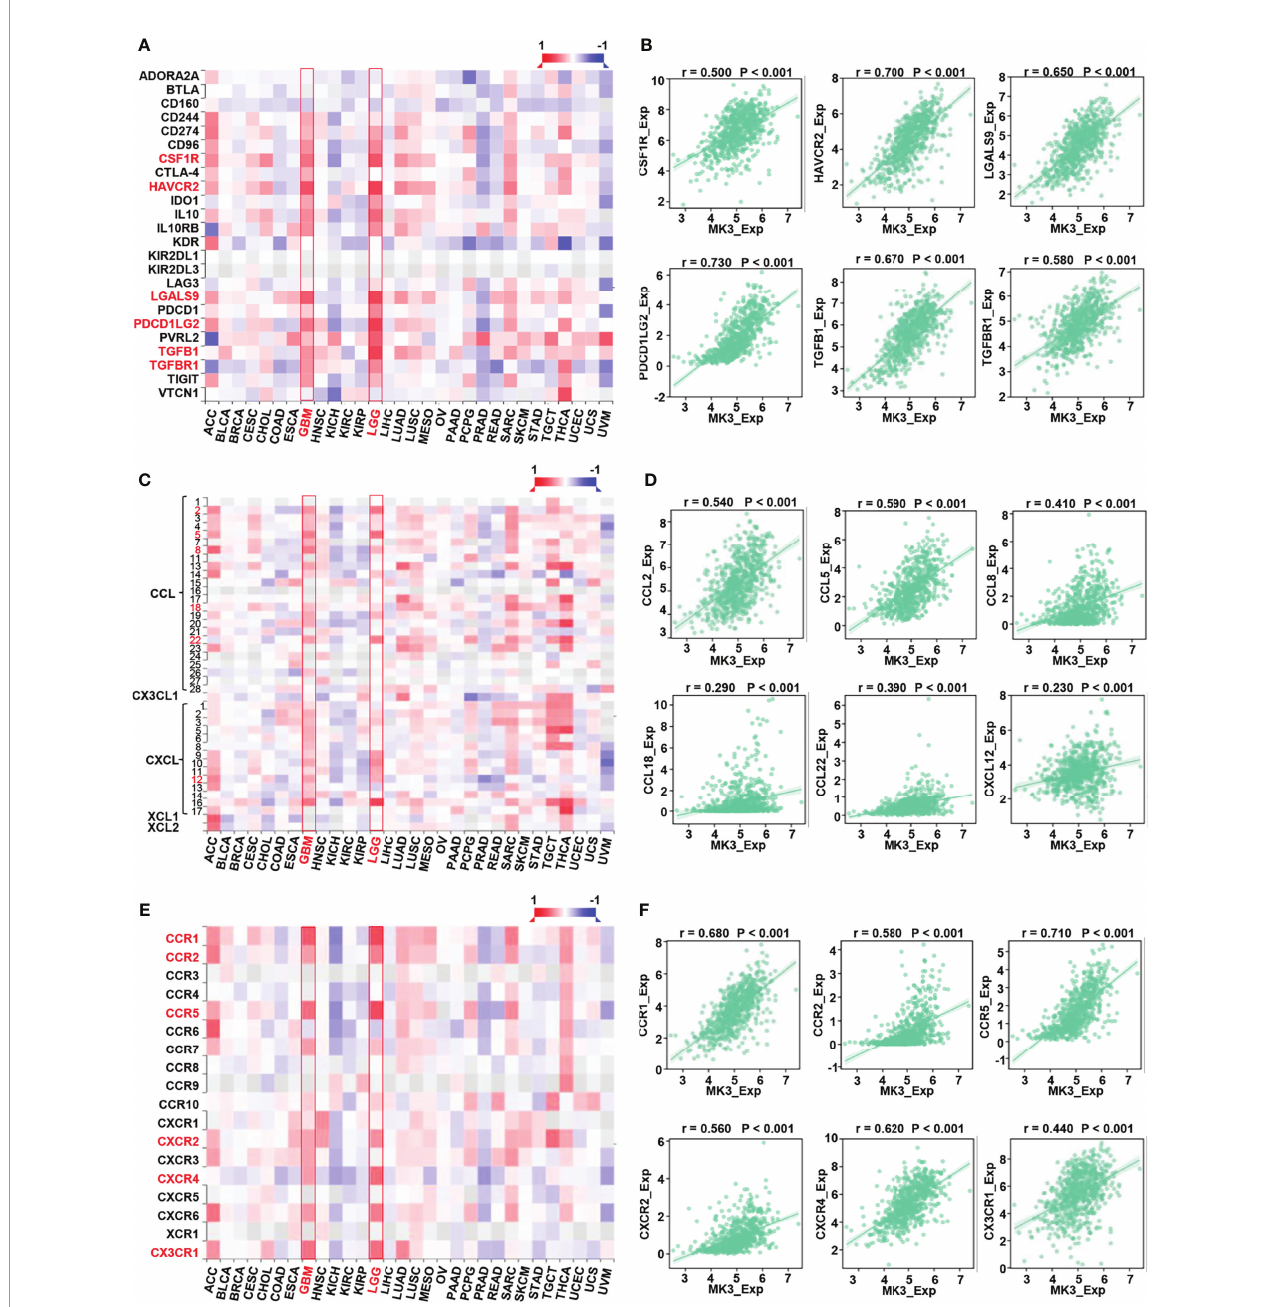
FIGURE 7 | Correlation between MK3 and immune regulated genes in glioma. (A) Correlation between the expression of MK3 and immunoinhibitors across human cancers. (B) The correlation analysis between the expression of MK3 and immunoinhibitor genes ( colony-stimulating factor 1 receptor , CSF1R ; hepatitis A virus cellular receptor 2 , HAVCR2 ; galectin 9 , LGALS9 ; programmed cell death 1 ligand 2 , PDCD1LG2 ; transforming growth factor beta 1 , TGFB1 ; and transforming growth factor beta receptor 1 , TGFBR1 ) in GBM and LGG samples from TCGA dataset. (C) Correlation between the expression of MK3 and chemokines across human cancers. (D) The correlation analysis between the expression of MK3 and chemokine genes ( C-C motif chemokine ligand 2 , CCL2 ; C-C motif chemokine ligand 5 , CCL5 ; C-C motif chemokine ligand 8 , CCL8 ; C-C motif chemokine ligand 18 , CCL18 ; C-C motif chemokine ligand 22 , CCL22 ; and C-X-C motif chemokine ligand 12 , CXCL12 ) in GBM and LGG samples from TCGA dataset. (E) Correlation between the expression of MK3 and chemokine receptors across human cancers. (F) The correlation analysis between the expression of MK3 and chemokine receptor genes ( C-C motif chemokine receptor 1 , CCR1 ; C-C motif chemokine receptor 2 , CCR2 ; C-C motif chemokine receptor 5 , CCR5 ; C-X-C motif chemokine receptor 2 , CXCR2 ; C-X-C motif chemokine receptor 4 , CXCR4 ; and C-X3-C motif chemokine receptor 1 , CX3CR1 ) in GBM and LGG samples from TCGA dataset. GBM, glioblastoma; LGG, low-grade glioma; TCGA, The Cancer Genome